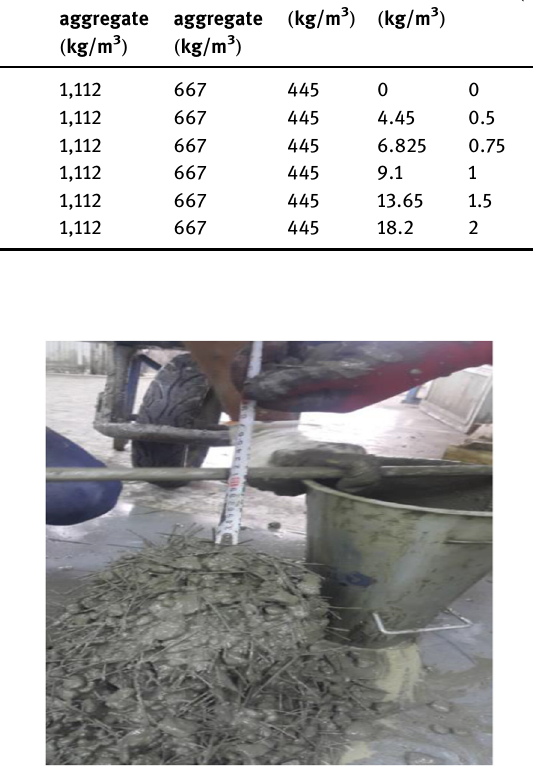
Table 7: Mix proportion and polyole fi n fi ber percentage Mix No. Coarse